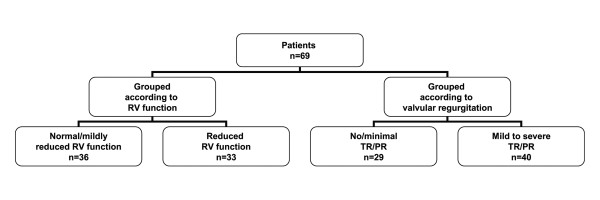
Patient subgroups. Flow chart showing patient subgroups based on either right ventricular (RV) function or the absence or presence of right-sided valvular regurgitation (TR/PR = tricuspid and/or pulmonary regurgitation).